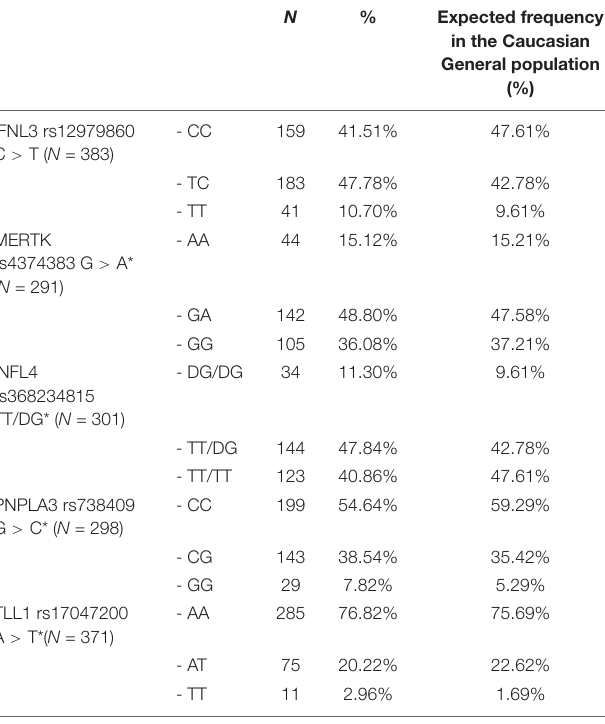
TABLE 3 | Genotype distribution for TLL-1 rs10747200 in respect to Hardy-Weinberg equilibrium. Genotypes Observed Expected Homozygote AA 285 280.3 Heterozygote 75 84.3 Homozygote TT 11 6.3